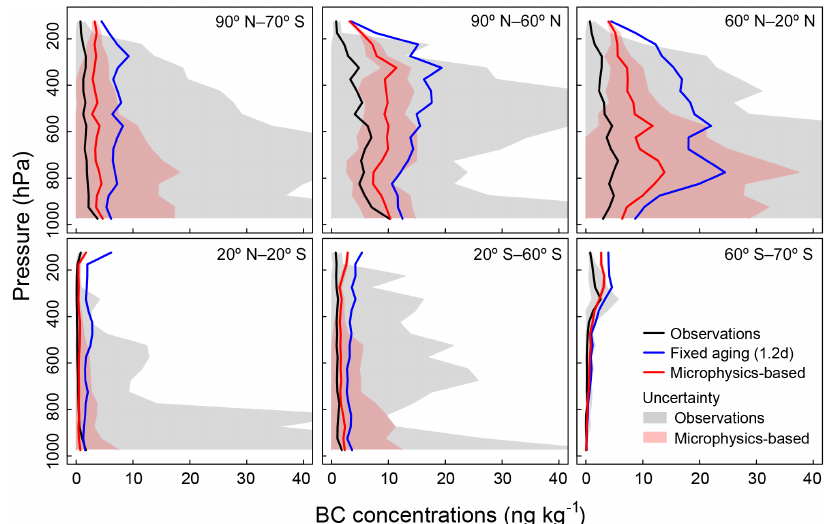
Figure 7. Median vertical profiles of HIPPO observed (black) and GEOS-Chem simulated BC concentrations at different latitudes. Results are averaged over 50hPa altitude bins. Model results using a fixed BC aging (blue) and a microphysics-based aging (red) are shown. Also shown are the 1 σ uncertainties of observations (grey) and model results (light red) from microphysics-based sensitivity simulations (see Table 1 and text for